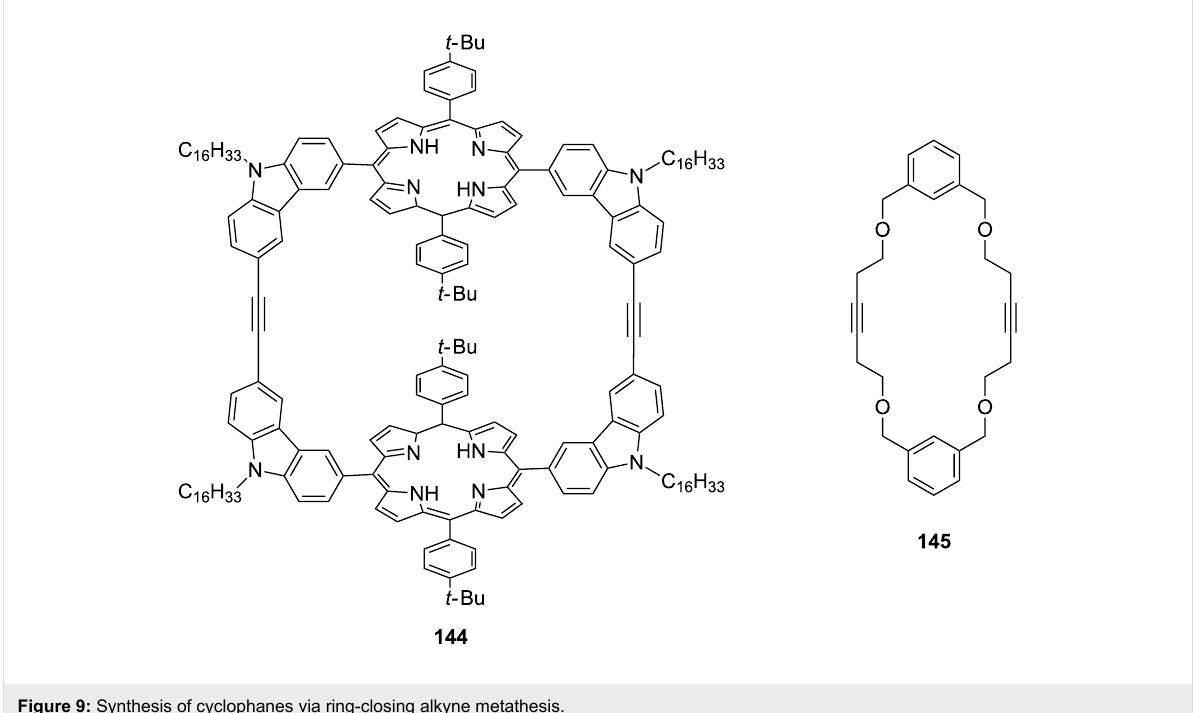
Figure 9: Synthesis of cyclophanes via ring-closing alkyne